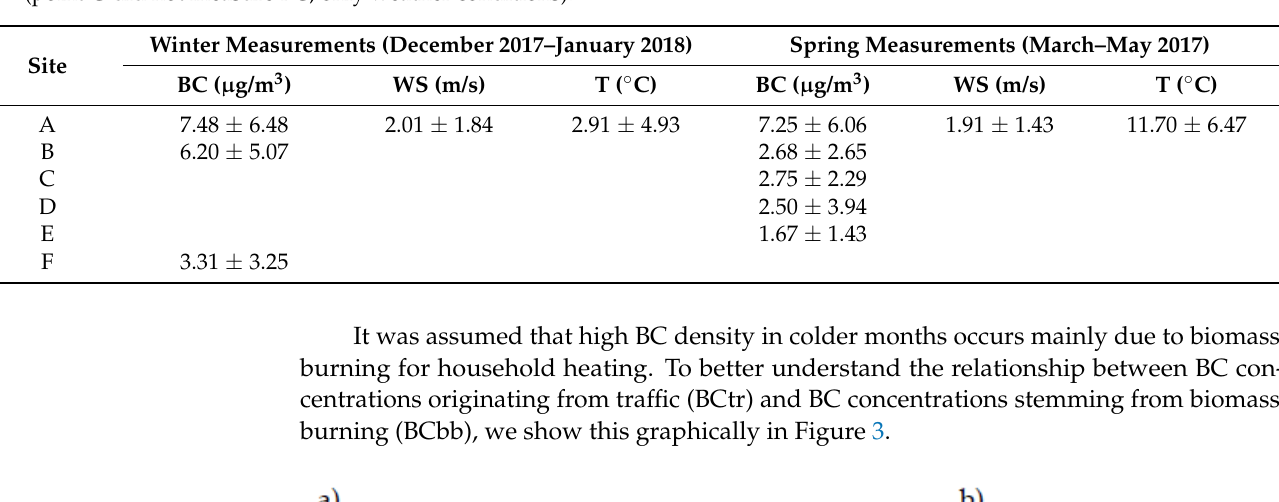
Table 2. Data on average BC concentration values, wind speed, and air temperature at measuring points A, B, C, D, E, and F (point G did not measure BC, only weather conditions).